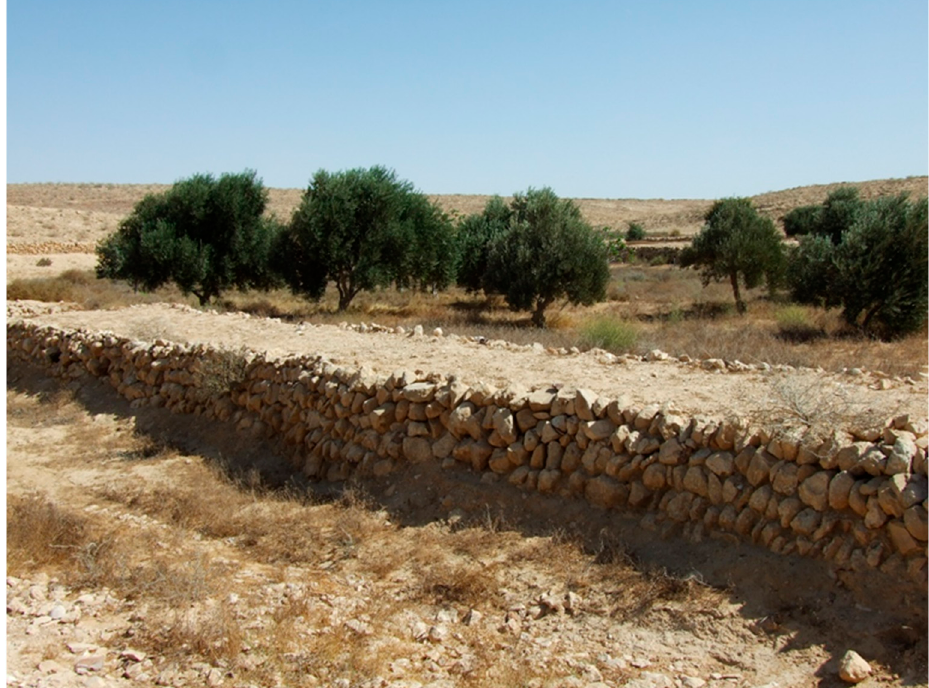
Figure 8. A reconstructed Type B agricultural terrace in the Negev Highlands designated for the cultivation of perennial plants, such as olive trees and vineyards. (Photograph: Y. Avni).